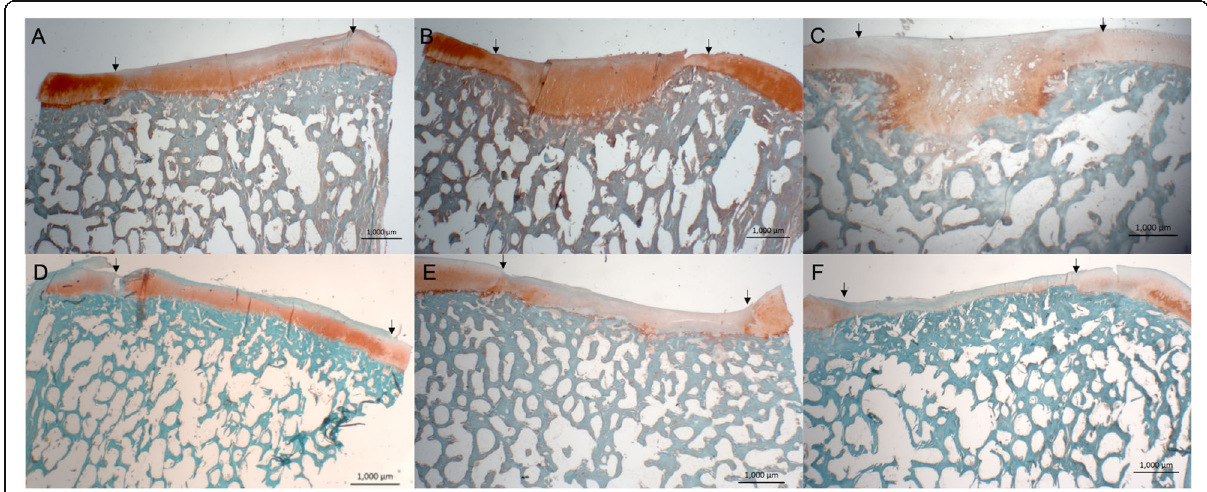
Fig. 4 Safranin O staining; scale bars: 1000 μ m. Magnification 12.5-fold. Defects treated with CB (A-C) and BMS (D-F). Images represent best (left), average (middle) and worst (right) repair. A larger extent of subchondral remodeling is seen in the CB treated defects, whereas there also seems to be a higher degree of metachromasia in CB treated defects